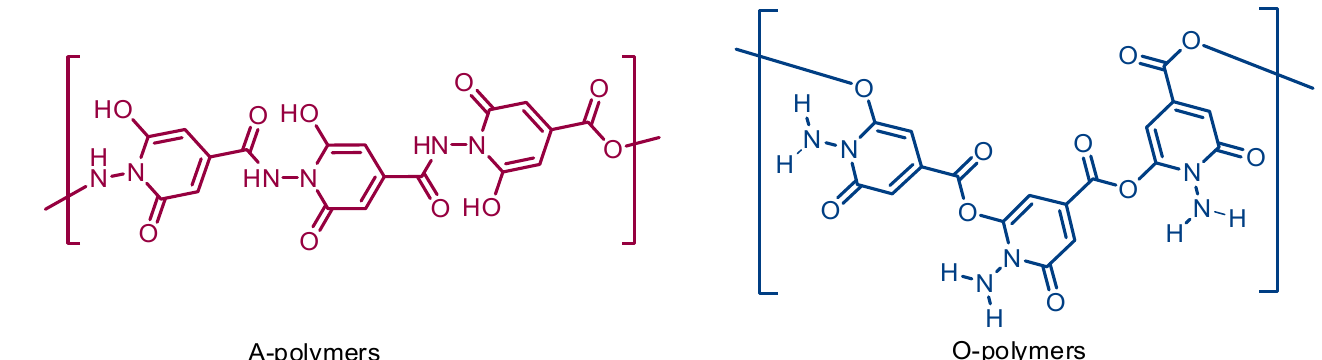
Scheme 2. Possible formation of polymeric chains for the Hy-CD case.